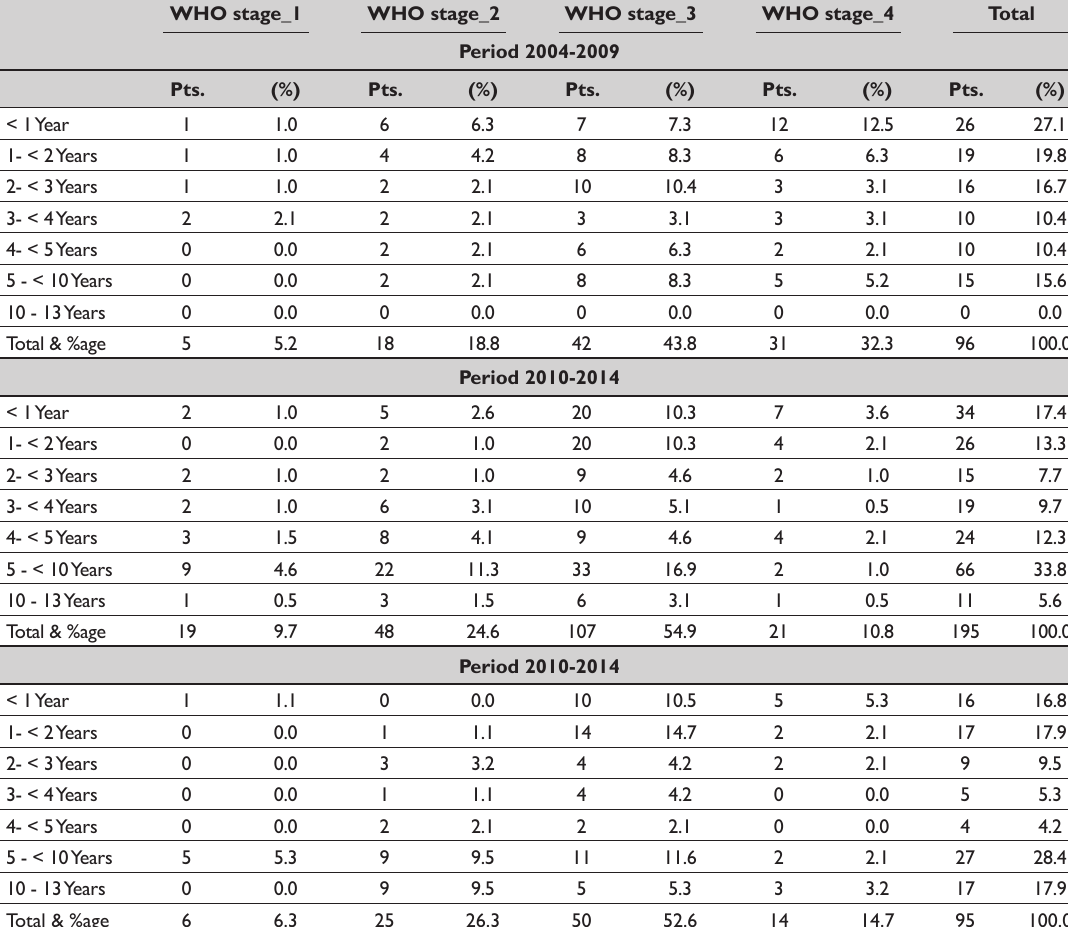
Table 2: The number and proportion (%) of patients (Pts.) by each age-group for each WHO-stage at the initiation of antiretroviral therapy (ART) in each policy period WHO stage_1 WHO